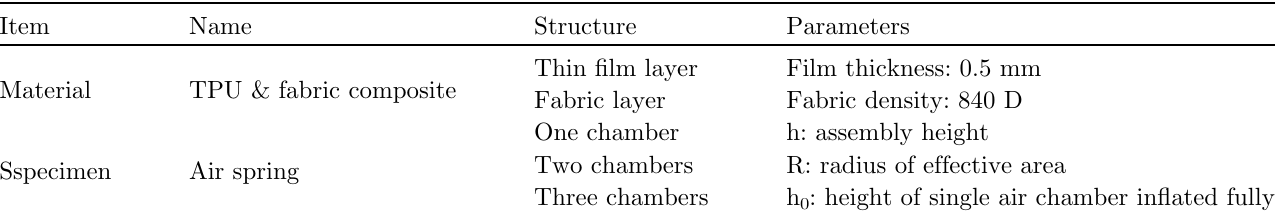
Table 1. Information of material and